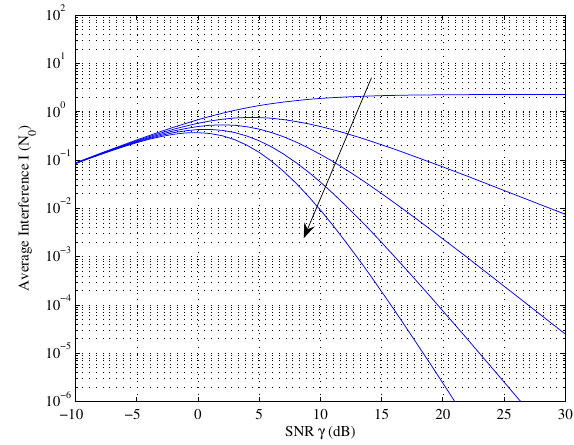
Figure 4. The reliability-oriented scheme for SCoS with η ≤ 0 . 01 . k = N 0 . Along the direction of the arrow, N = 1 , 2 , 3 , 4 , 5